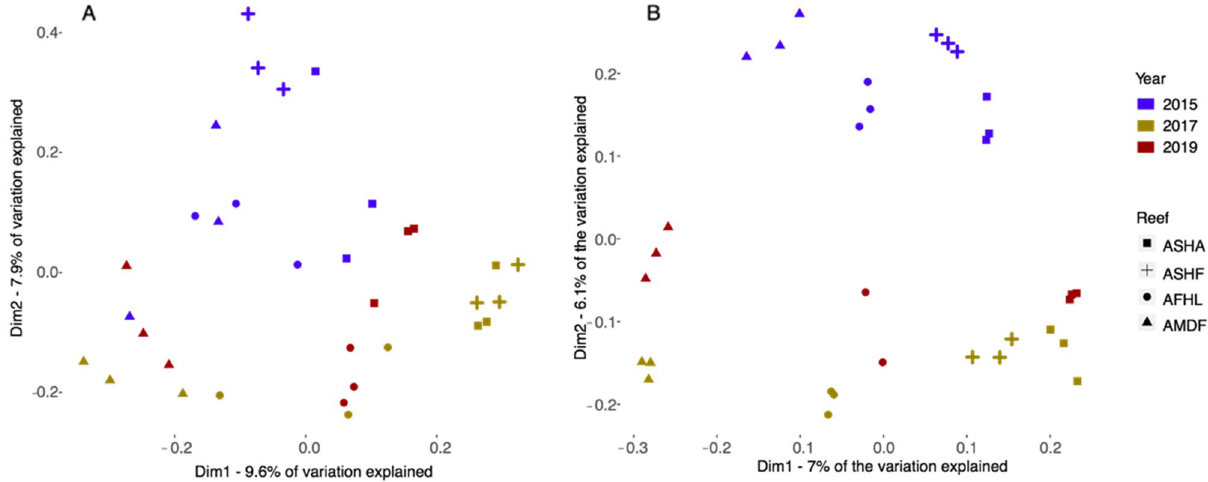
Figure 3. Principal coordinate analysis of the ( A ) barcoding > 2000 µm and ( B ) metabarcoding 106–2000 µm fractions using the presence absence matrix and the Jaccard dissimilarity metric to assess differences in the community composition between reefs and time. Reef names are abbreviated as: ASHA Abu Shoosha, ASHF Abu Shootaf, AFHL Al Fahal, and AMDF Abu sampling period, with higher similarity among the communities across the shelf in 2015 (for the 106–2000 µm fraction), becoming more dissimilar after the bleaching event (i.e., samples from different reefs in 2017 and 2019 are farther apart in the plot). Reefs were significantly different from each other except Abu Shoosha and Al Fahal as revealed in the post-hoc test of the PERMANOVA (Table S-3). A similar trend was observed for the metabarcoded fraction (106–2000 µm) with a significant interaction (PERMANOVA p < 0.01; Table S-2) for both Jaccard and Bray–Curtis. Significant differences between all sampling times and between all reefs were also observed (Table S-3). For both the barcoding and metabarcoding datasets, turnover was a higher component of beta diversity than nestedness. For the barcoding dataset, different patterns were observed for turnover and nestedness temporally at the reef level. At the offshore reef Abu Madafi, turnover ( p < 0.01; Fig. 4A) and nestedness ( p = 0.02; Fig. 4A) were significantly lower in 2017–2019 while for the nearshore reef, Abu Shoosha, it was the period 2015–2017 showing significantly lower values (turnover p < 0.01; nestedness p = 0.03; Fig. 4A), when compared to the other pairs of sampling periods. There were no significant differences in turnover and nestedness between sampling periods in Al Fahal (midshore reef). Comparisons amongst reefs within years showed that the only significant difference in turnover was in 2019 between Abu Shoosha and Abu Madafi ( p < 0.01; Fig. 4B). There were no significant differences in nestedness between sampling dates or reefs. In the metabarcoding dataset the only significant temporal differences in turnover—observed in all reefs occurred between 2017 and 2019 ( p < 0.01 in all reefs; Fig. 4A), where turnover was significantly lower than for the remaining comparisons. However, while nestedness was higher for the 2017–2019 comparison in Abu Shoosha ( p < 0.01) and Al Fahal ( p < 0.01), this pattern was not observed in Abu Madafi where the 2015–2017 comparison was significantly lower ( p < 0.01). Comparisons amongst reefs showed that in 2017 and 2019 all reefs had a significantly different turnover (2017 p < 0.01; 2019 p < 0.01; Fig. 4B) while in 2015 only the comparison between Abu Madafi and Abu Shoosha was significantly different ( p < 0.01). In terms of nestedness the only significant difference was observed in 2019 between Abu Madafi and Abu Shoosha ( p = 0.01). Spatio‑temporal indicators. We identified 18 OTUs with a significant contribution to the differences in spatio-temporal patterns (Fig. 5). Two hermit crabs (Paguridae OTU_4 and OTU_108), two shrimps ( Exo- climenella OTU_60 and Palaemonella pottsi OTU_46), two squat lobsters ( Galathea OTU_90, Phylladiorhynchus